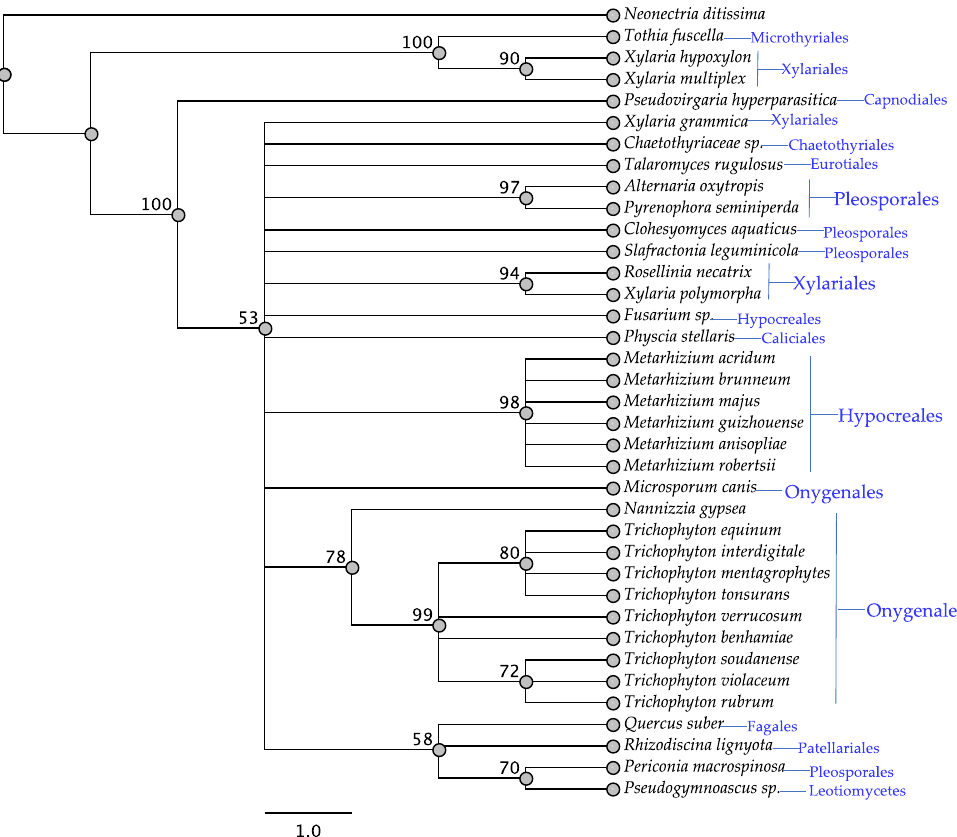
Figure 2. Maximum parsimony protein tree resulting from the analysis of SwnH2. Bootstrap confidence values from 1000 bootstrap replicates are presented at each corresponding node. Neonectria ditissima (Hypocreales) was used as the outgroup and obtained from NCBI database, GenBank accession: KPM44118.1. Fungal orders are indicated next to each organism/clade.